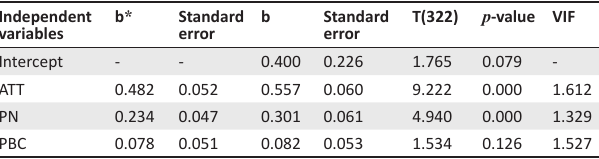
TABLE 4: Influence of independent variables on intention to implement an environmental management system ( N =